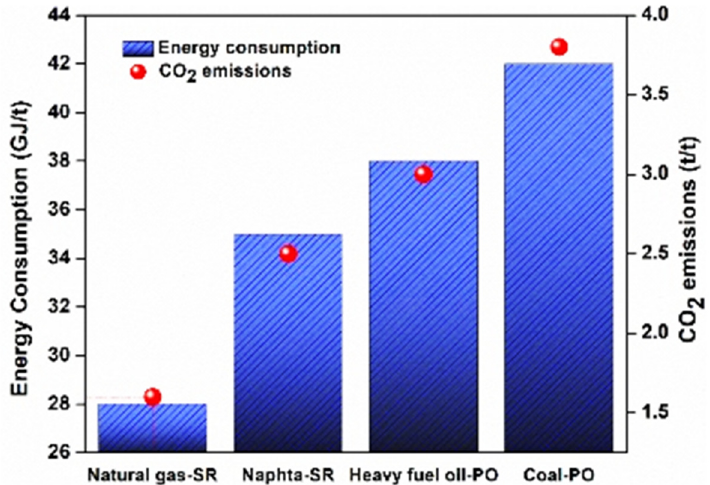
Figure 13. Comparison of energy consumption (GJ/t NH 3 ) of various ammonia production technologies and their CO 2 emissions (t CO 2 /t NH 3 ). Reprinted with permission [75].